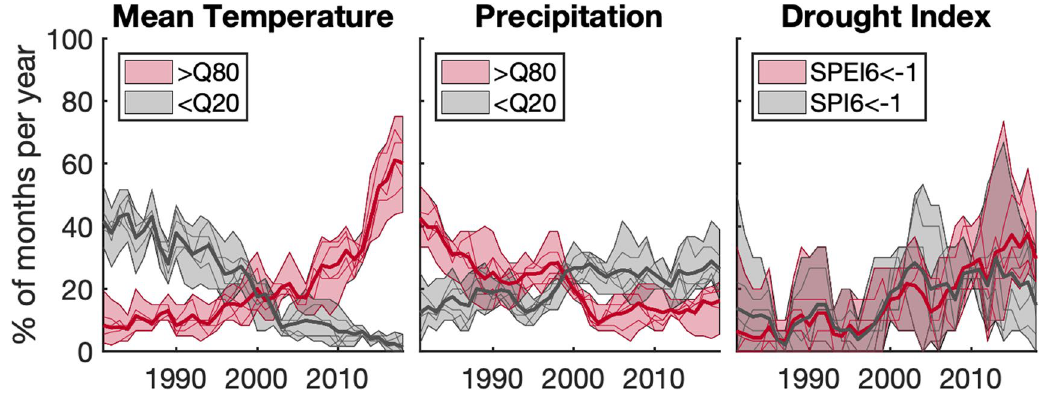
Figure 2. Relative frequency of climate variables from 1981–2018. From left to right the relative frequency of ERA5 mean temperature ( T , left), total precipitation ( P , middle) and drought index (SPEI, right) exceeding the respective quantile event thresholds (< Q20, > Q80, < − 1 ) are shown for the basin-averages of Extended São Francisco, Niger, Volta, Atbara, Blue Nile and Karun. The thick solid lines denote the mean relative frequency over the 6 basins, and the shaded areas encompass the thin solid lines for the 5-year moving averages of relative frequencies of the individual